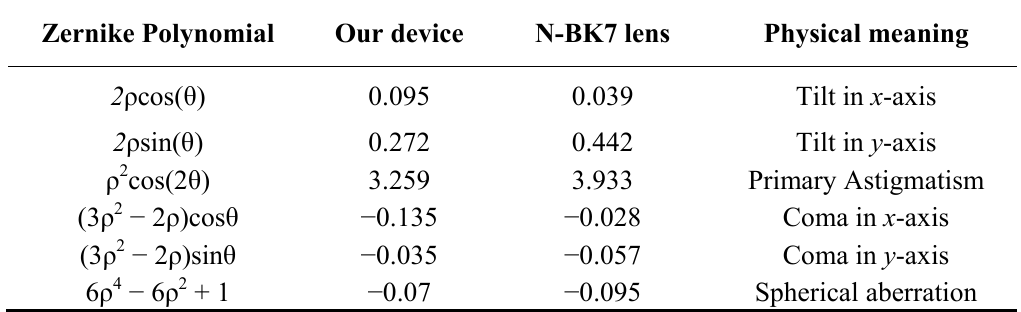
Table 1. Zernike coefficients of our device and a commercial refractive cylindrical lens (N-BK7) characterized by Shack-Hartmann wavefront sensor